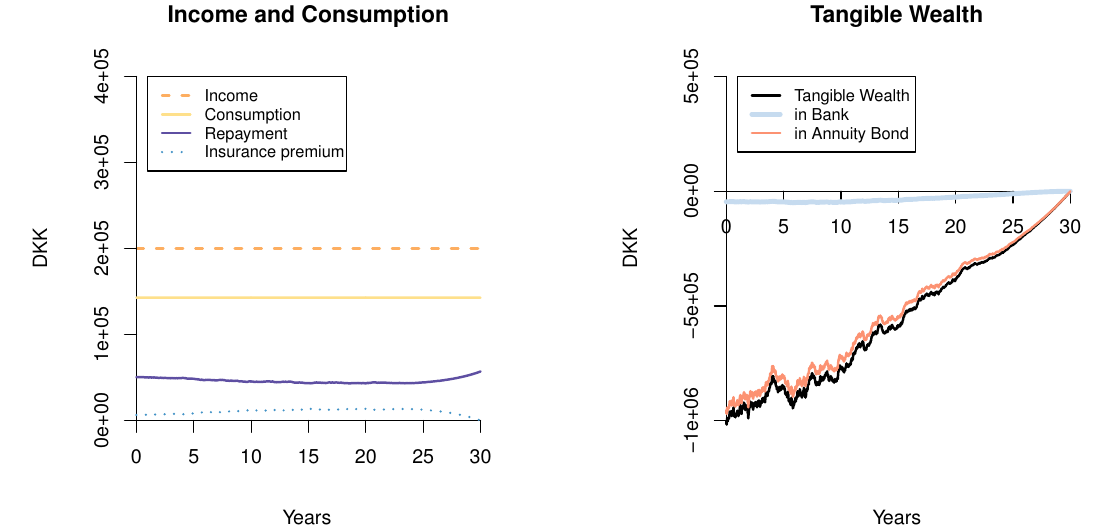
Figure 2. Infinitely risk-averse investor with constant labor income and with mortality